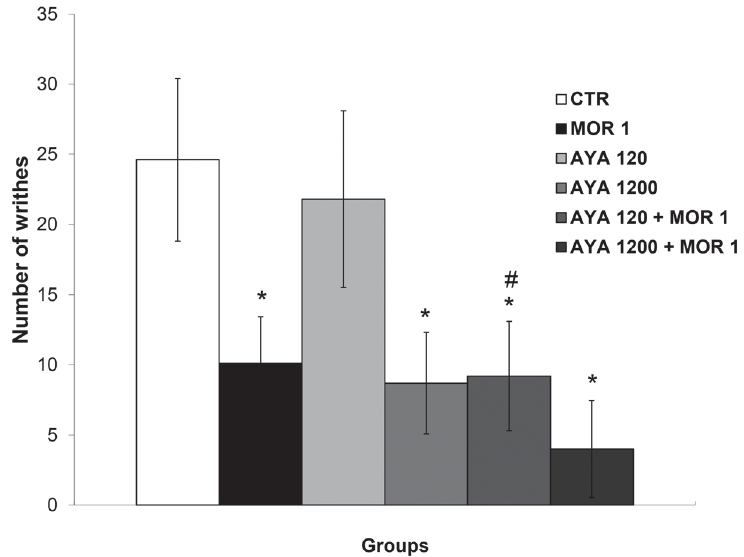
FIGURE 4 - Effect of ayahuasca (AYA, 120 and 1200 mg/kg, p.o.) and its association with morphine (MOR, 1 mg/kg, i.p.) on the number of writhes induced by acetic acid (0.8%, i.p.). Results are expressed as the mean ± SEM (n=10). (*) p <0.05: statistically different from control; (#) p <0.05: statistically different from AYA 120. ANOVA followed by Duncan’s